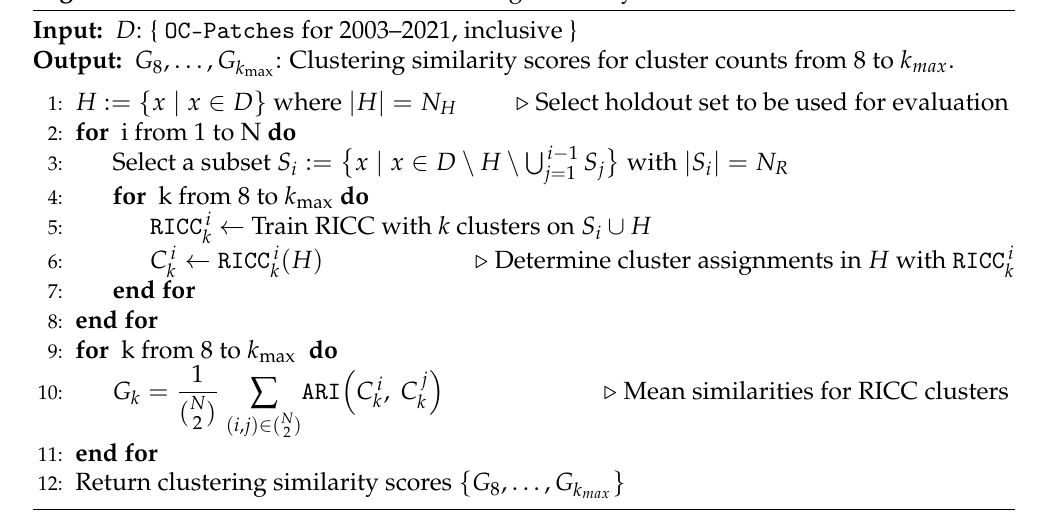
Algorithm A1 Pseudocode for the clustering similarity test described in Section